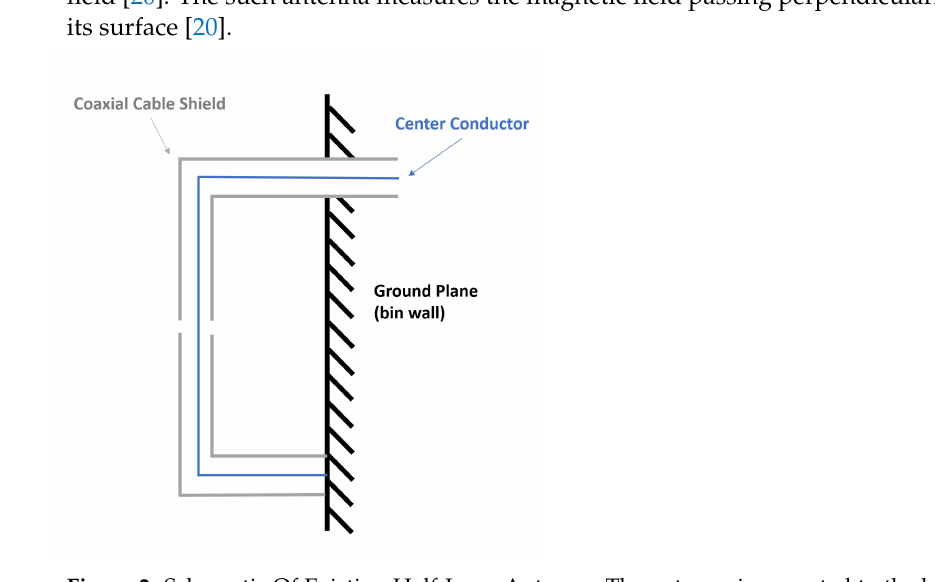
Figure 2. Schematic Of Existing Half-Loop Antenna. The antenna is mounted to the bin wall and consists of a coaxial cable loop with a cut in the outer shield of the cable at the center of the